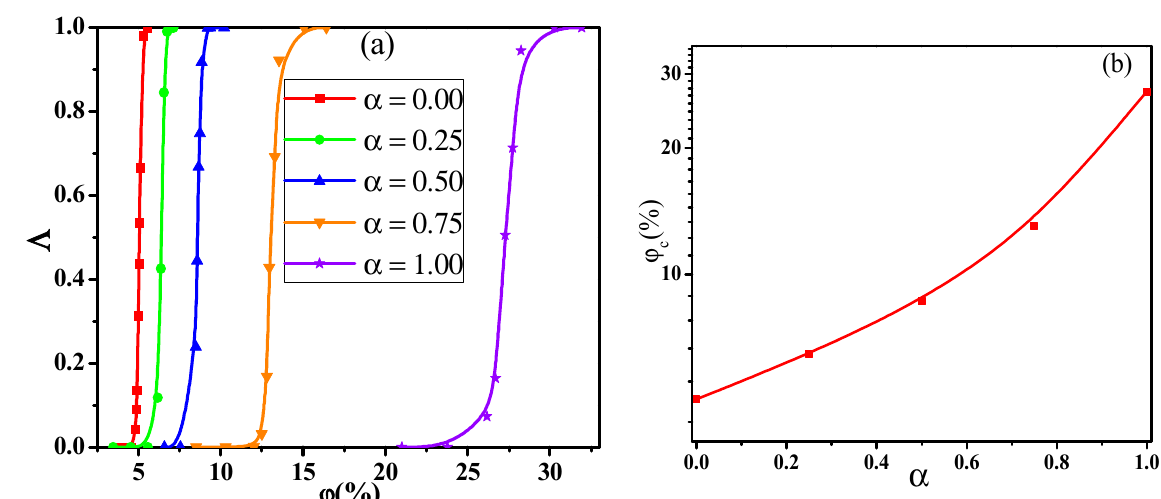
Figure 1. ( a ) Conductive probability Λ with the concentration ϕ of nanoparticles and ( b ) the percolation threshold ϕ c in respect of the mixing ratio ( α